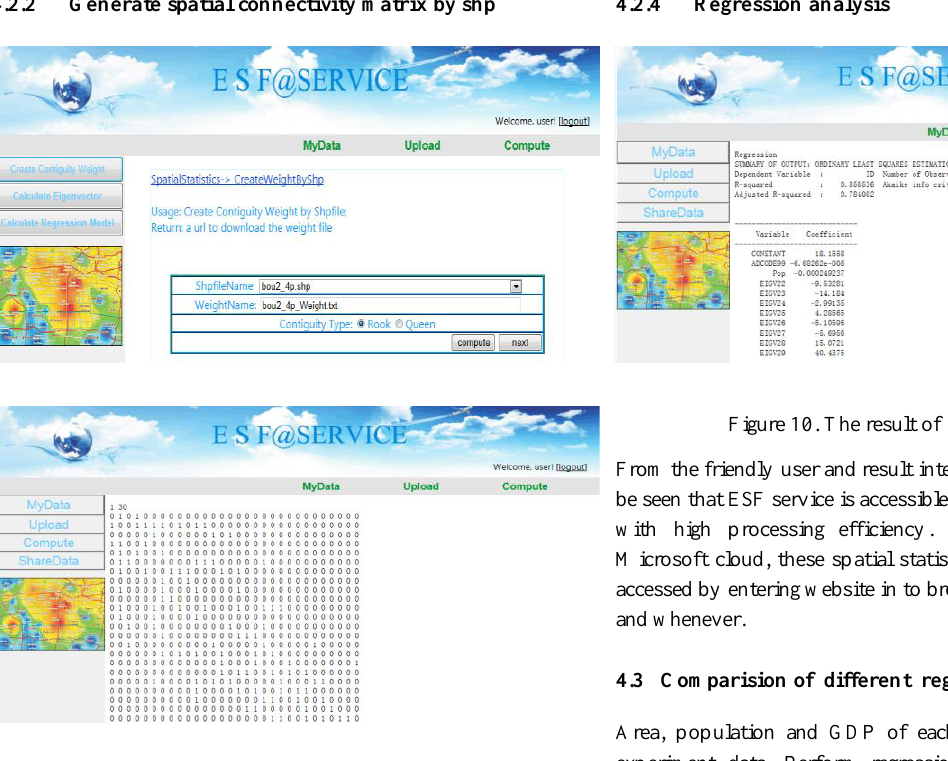
Figure 8. The result of connectivity matrix